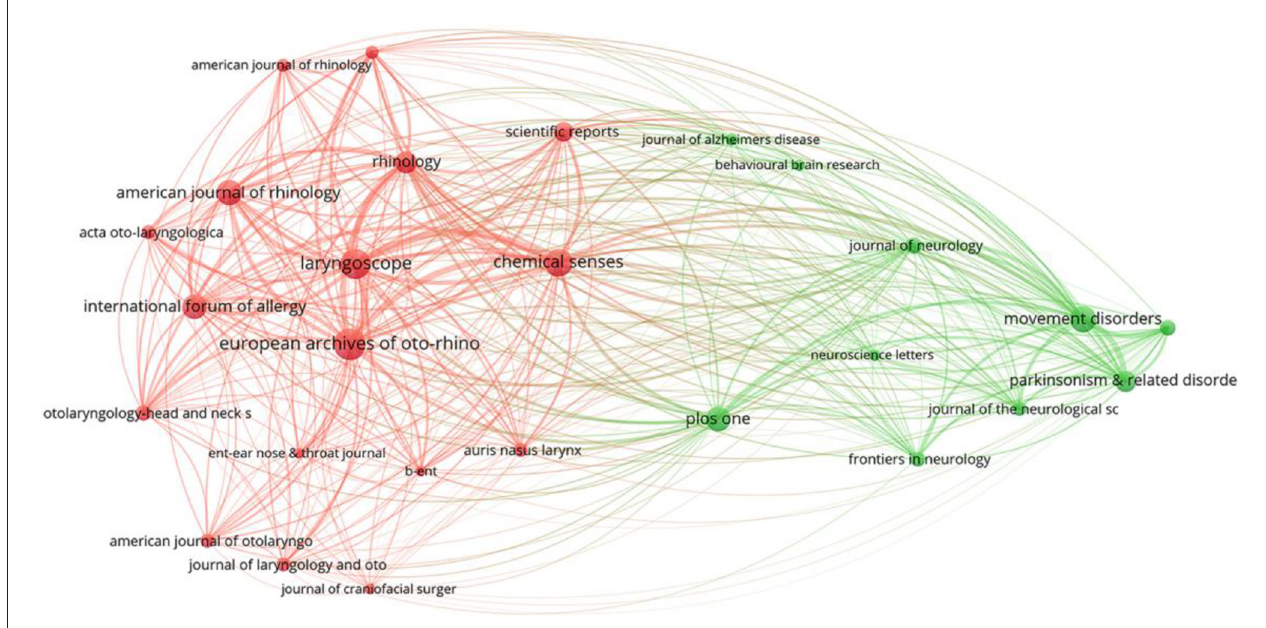
FIGURE 5 | A network map showing the journals that have published research on olfactory dysfunction.